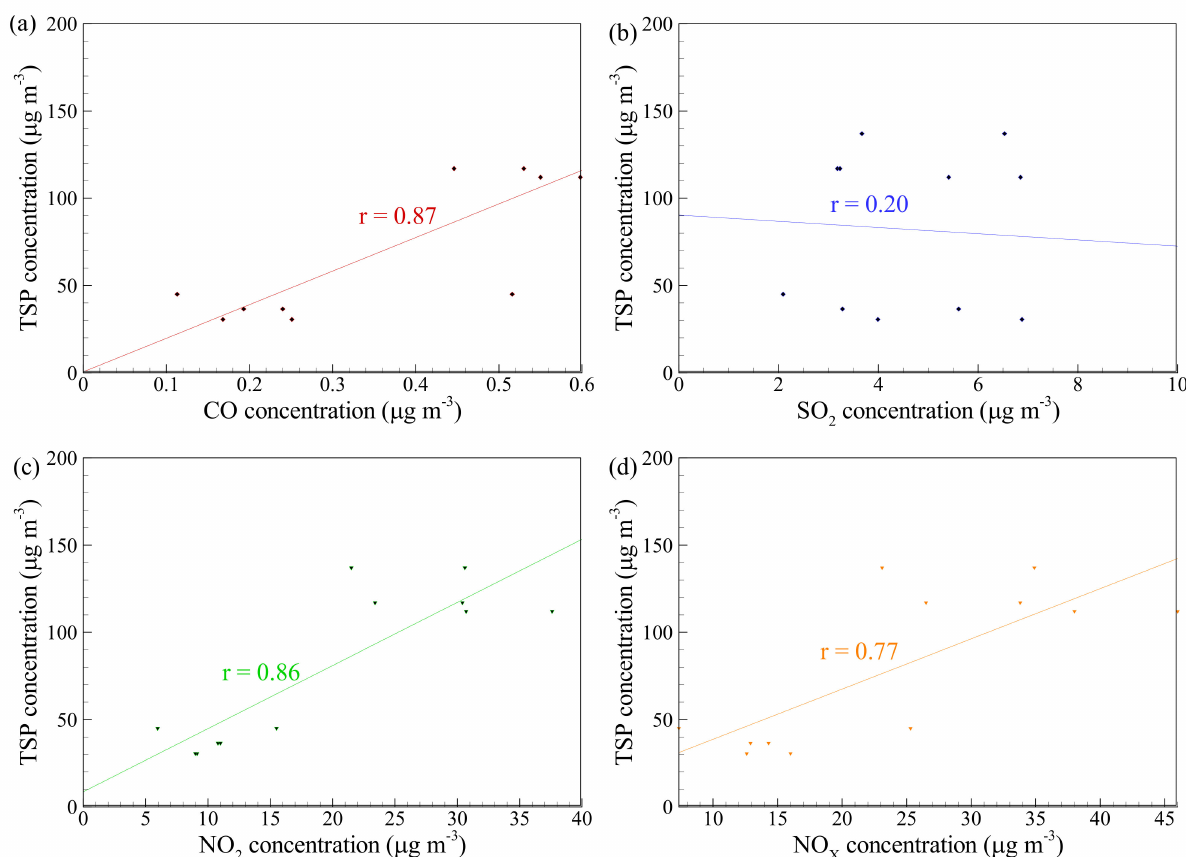
Figure 4. Pearson correlation values for ( a ) CO, ( b ) SO 2 , ( c ) NO 2 , and ( d ) NO X concentrations with the average TSP